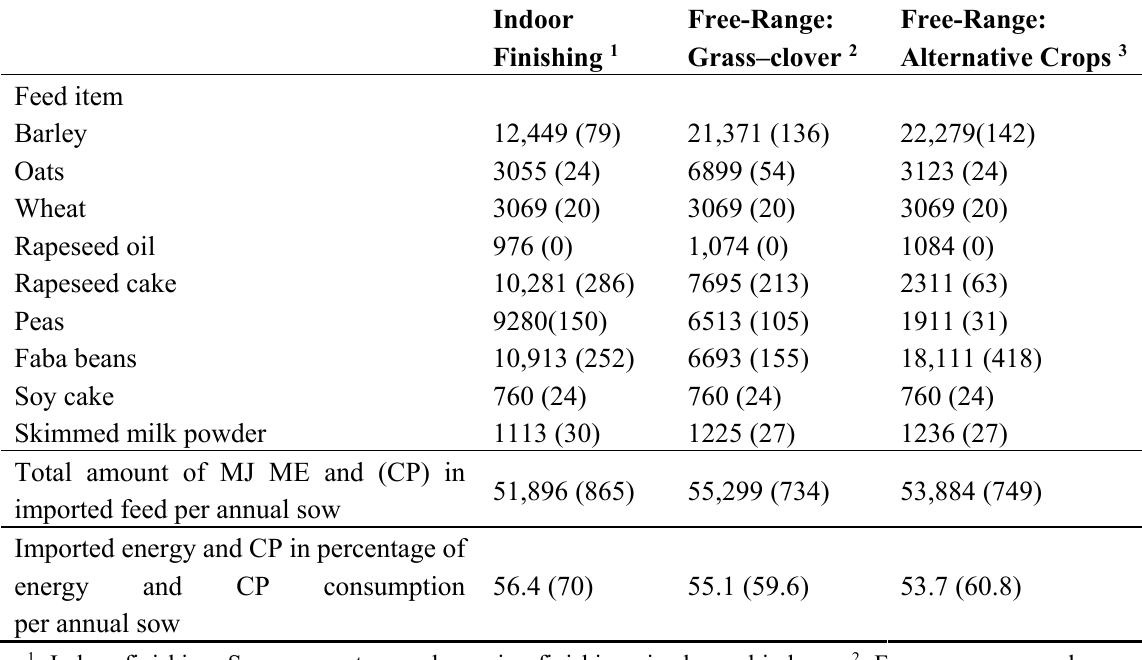
Table 5. Imported feed in MJ metabolizable energy (ME) and kg crude protein (CP) (brackets) per annual sow in three organic pig production